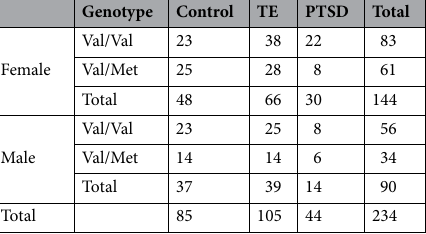
Table 2. Sex and BDNF genotype frequency distribution across